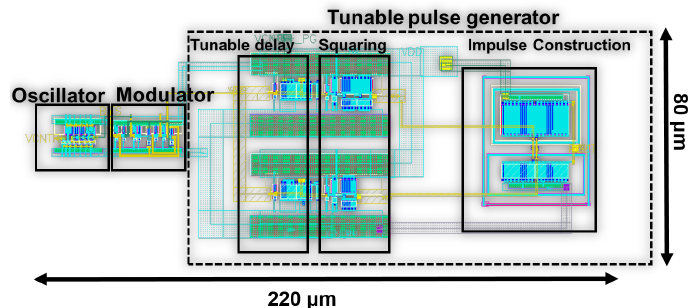
Figure 4. IC layout of the IR-UWB